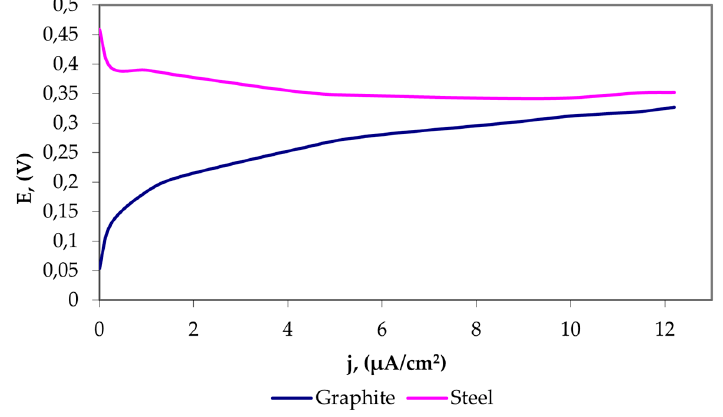
Figure 6. Corrosion diagram of a steel sample with an unpainted phosphate coating.